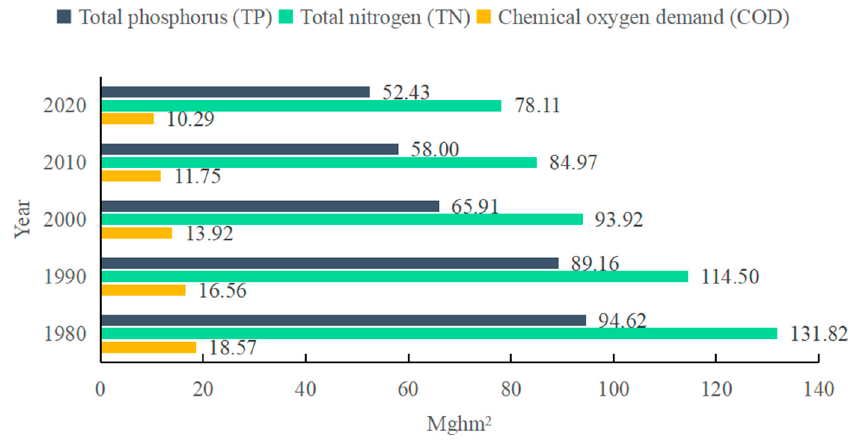
Figure 4. The WEF of pollution account in Japan during 1980–2020.